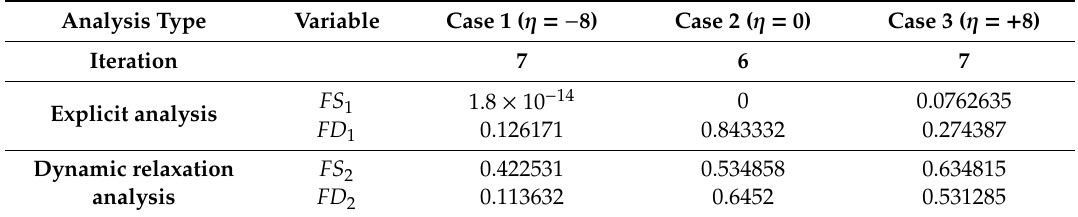
Table 4. Curve fitting results for Ogden’s incompressible